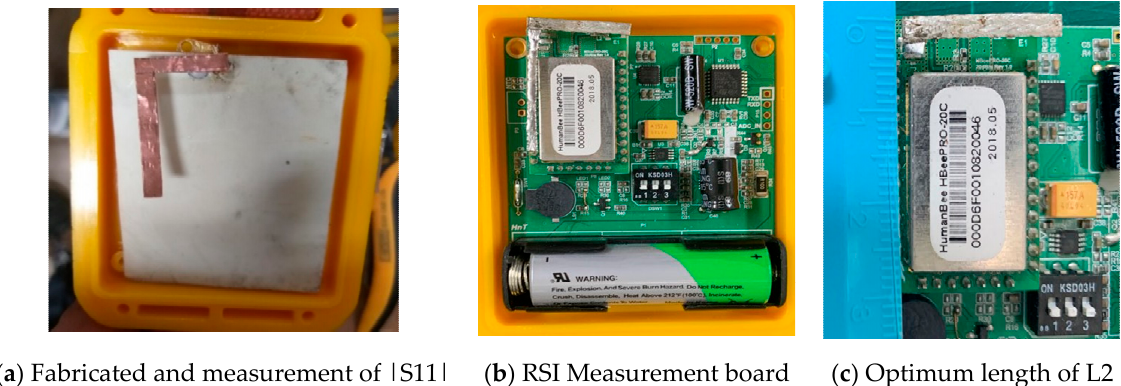
Figure 10. Fabricated and tested IFA antenna with RF board and RF module and optimum length of L2.